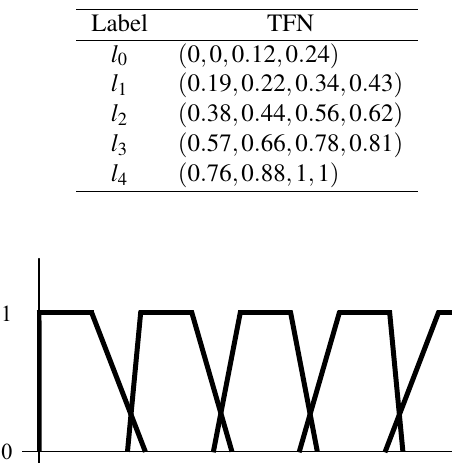
Table 1. An example of five well-balanced linguistic labels.